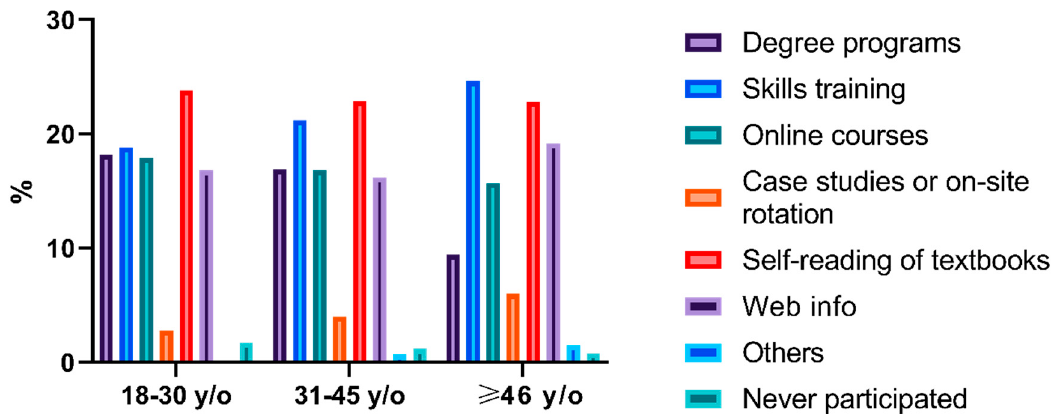
Figure 1. Histogram of capacity enhancement activities based on age.